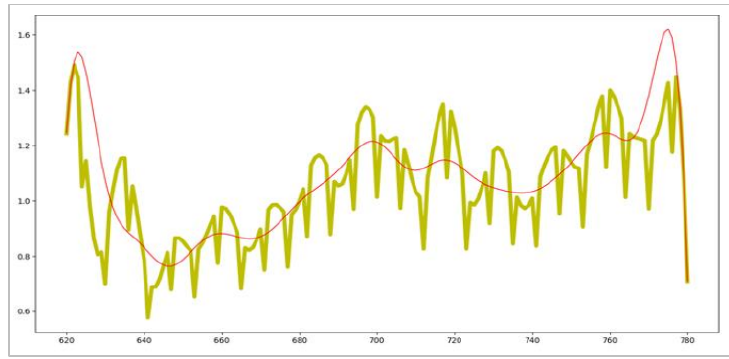
Figure 5. Smoothing process of trajectory.